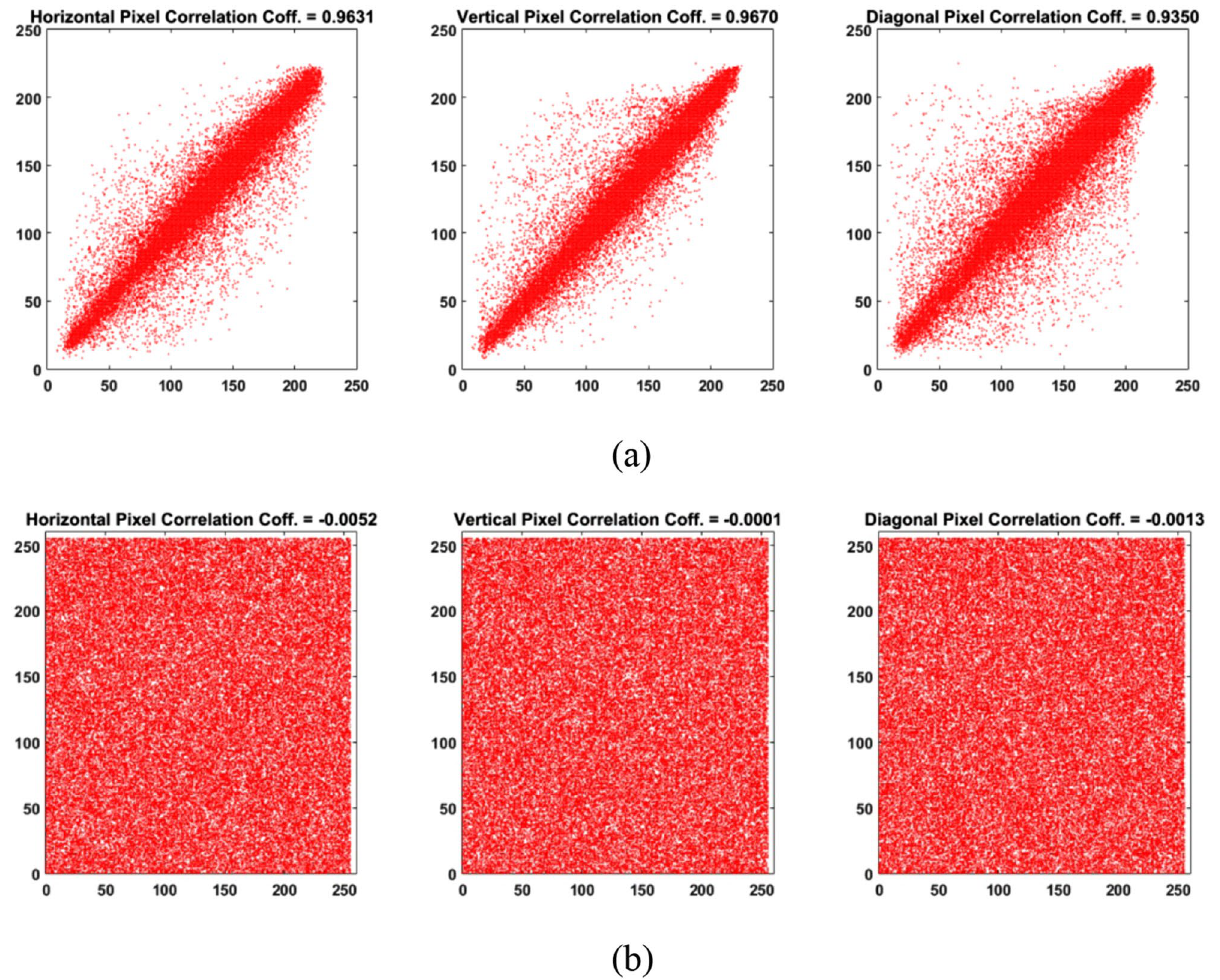
Figure 11. Adjacent pixel values in horizontal, vertical, and diagonal directions in ( a ) Peppers and ( b ) encrypted Peppers for the red